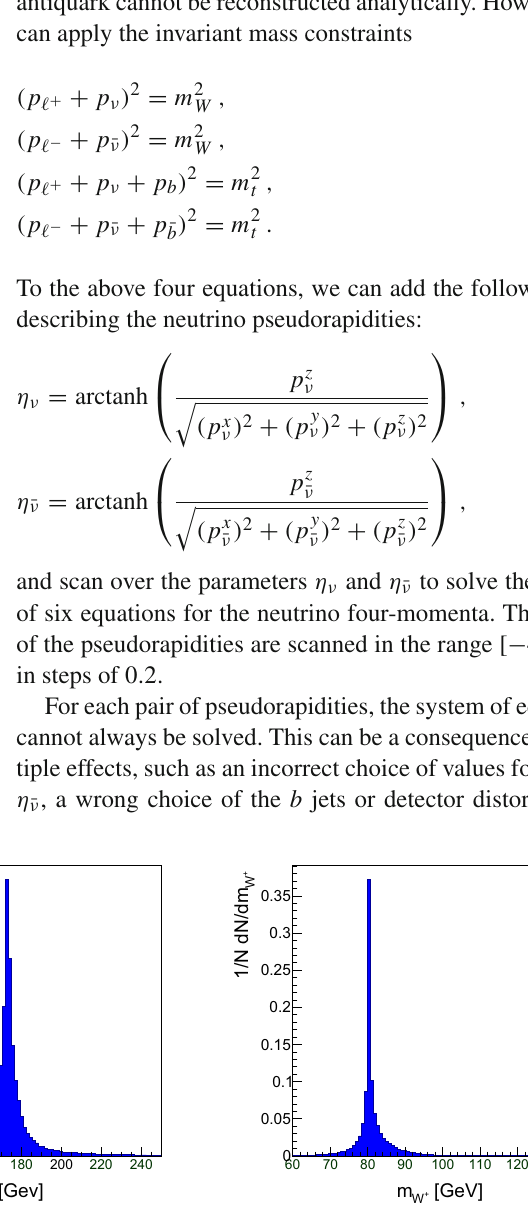
Fig. 1 The χ 2 (left), top quark mass (centre) and W boson mass (right) normalised distributions are represented, after